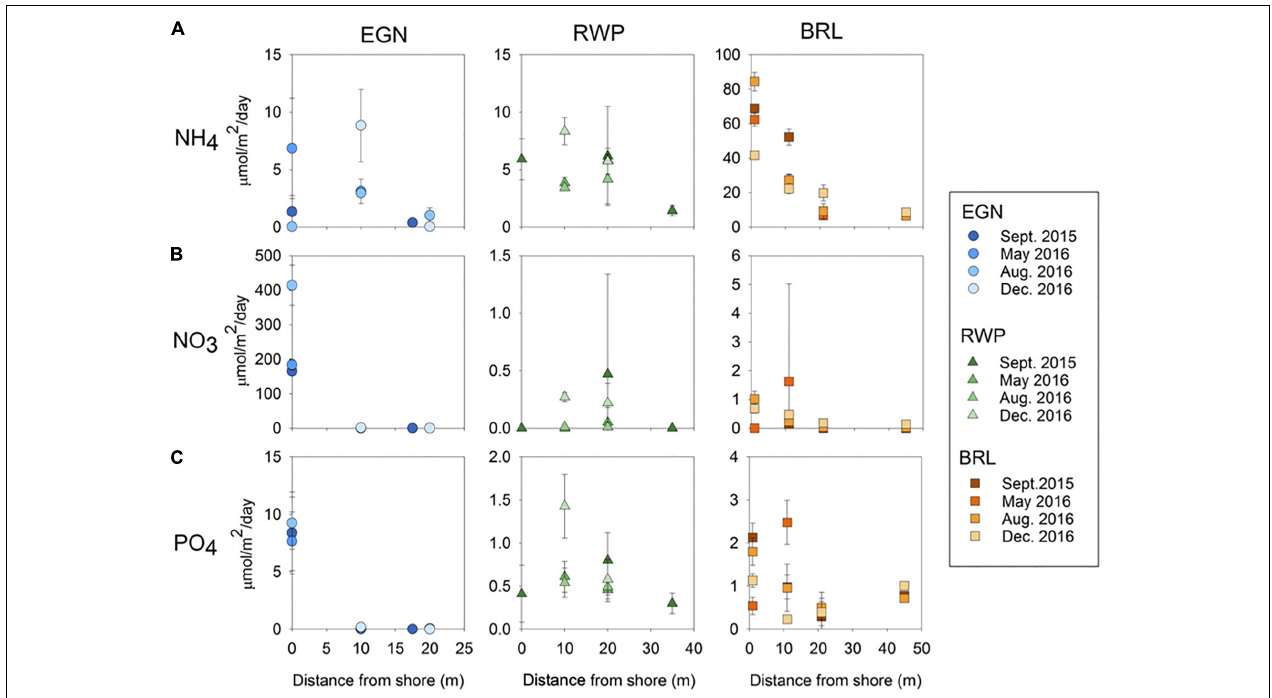
FIGURE 6 | Fluxes of nutrients of (A) NH 4 , (B) NO 3 , and (C) PO 4 at each piezometer versus distance offshore at each seepage face over time. Nutrient fluxes are calculated for each piezometer by multiplying specific discharge by the average concentration of nutrient samples in piezometer pore water samples for each sampling time. Error bars represent the standard deviation of calculated nutrient fluxes based on the standard deviation of nutrient concentrations in piezometers ( Supplementary Figures 1–3